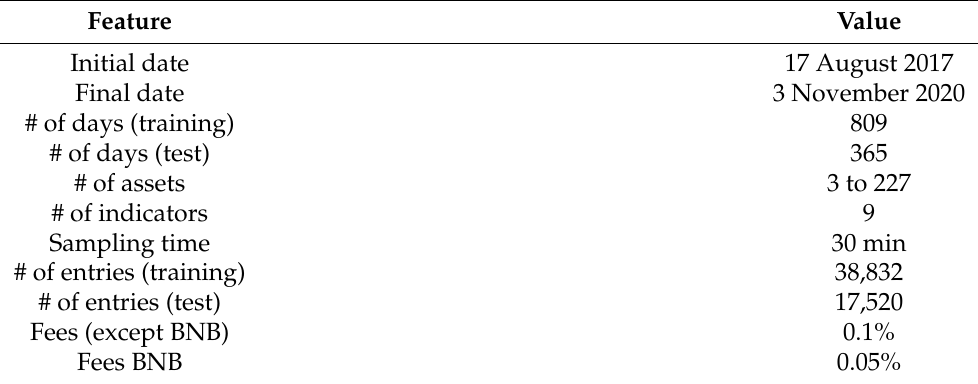
Table 2. Dataset